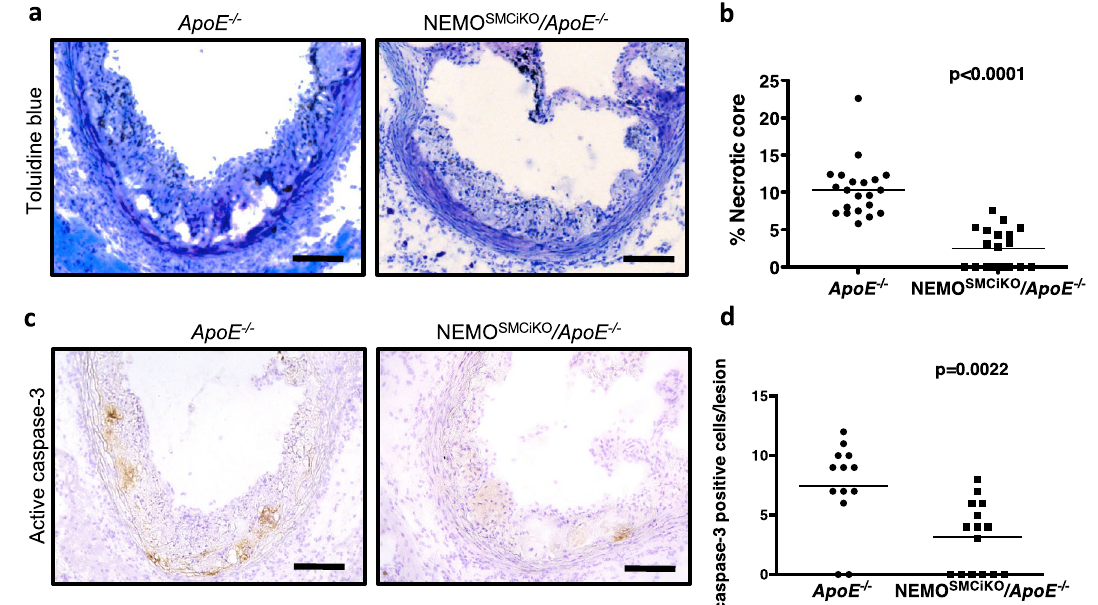
Figure 3. Reduced necrotic core and apoptosis in the aortas of ApoE − / − mice with inducible deletion of NEMO in smooth muscle cells. Male ApoE − / − and NEMO SMCiKO / ApoE − / − mice were fed a HFD for 10 weeks before sacrifice. ( a ) Representative pictures from atherosclerotic lesions of ApoE − / − or NEMO SMCiKO / ApoE − / − mice, where the necrotic acellular areas can be seen. Scale bars = 0.1 mm. ( b ) Graph showing quantification of the percentage of the necrotic area within the lesions of ApoE − / − or NEMO SMCiKO / ApoE − / − mice (Mann–Whitney test). ( c ) Representative pictures from atherosclerotic lesions of ApoE − / − or NEMO SMCiKO / ApoE − / − mice, stained with antibodies against active caspase-3. Scale bars = 0.1 mm. ( d ) Graph showing quantification of the percentage of apoptotic cells within the lesions of ApoE − / − or NEMO SMCiKO / ApoE − / − mice after 10 weeks on HFD (Mann–Whitney